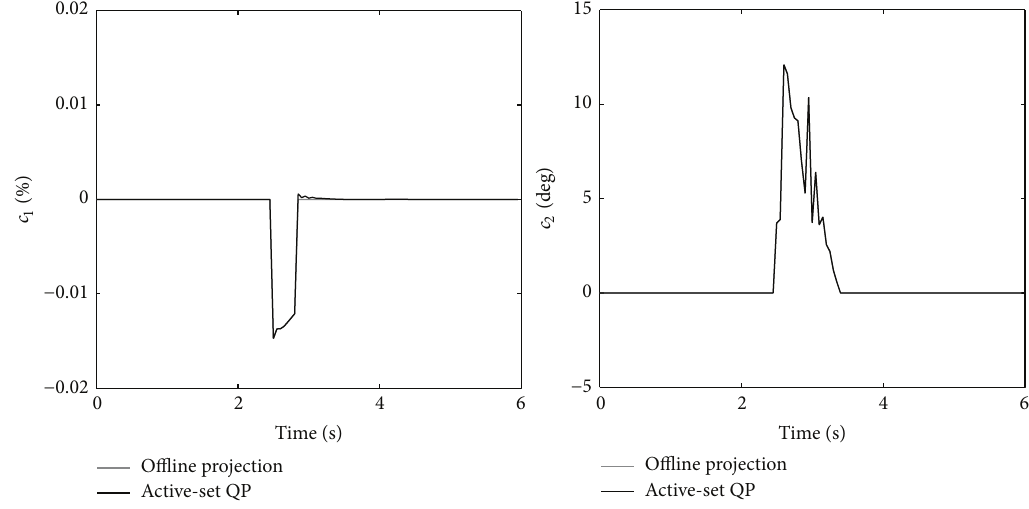
Figure 10: Nonlinear MPC corrections during capture of flight path